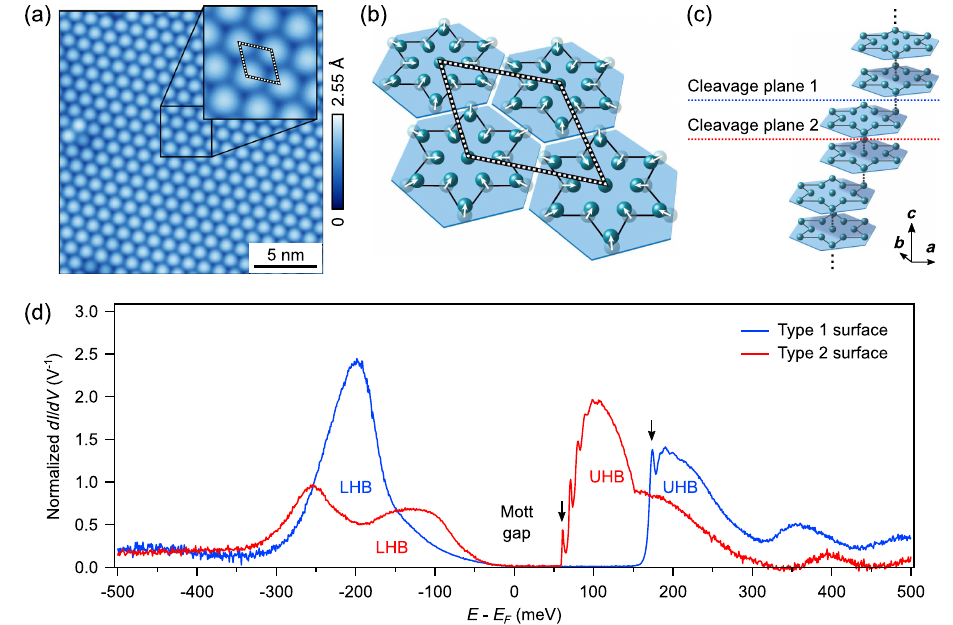
FIG. 1. Spectroscopically distinct surface terminations of the three-dimensional charge order in 1 T -TaS 2 . (a) A typical constant- current topograph ( V ¼ 250 mV, I ¼ 250 pA), acquired at a type 1 surface. (b) A depiction of the periodic lattice distortion forming SD clusters with 13 Ta atoms each (sulfur ions are neglected). A surface-projected supercell of the CDW distortion is shown with a black and white dashed line, corresponding to the cell shown in the inset of (a). (c) The alternating interlayer stacking of the SD clusters, showing the two inequivalent cleavage planes 1 and 2. (d) High-resolution ð dI=dV Þð V Þ curves acquired at two types of surface. Recent STM investigations allow the identification of each spectrum with the type 1 and 2 surfaces formed by cleavage through the planes 1 and 2 in (c) [5]. The newly observed peaks at each surface are indicated with arrows. For ease of comparison, the curves are normalized by dividing by the current value at þ 500 mV for